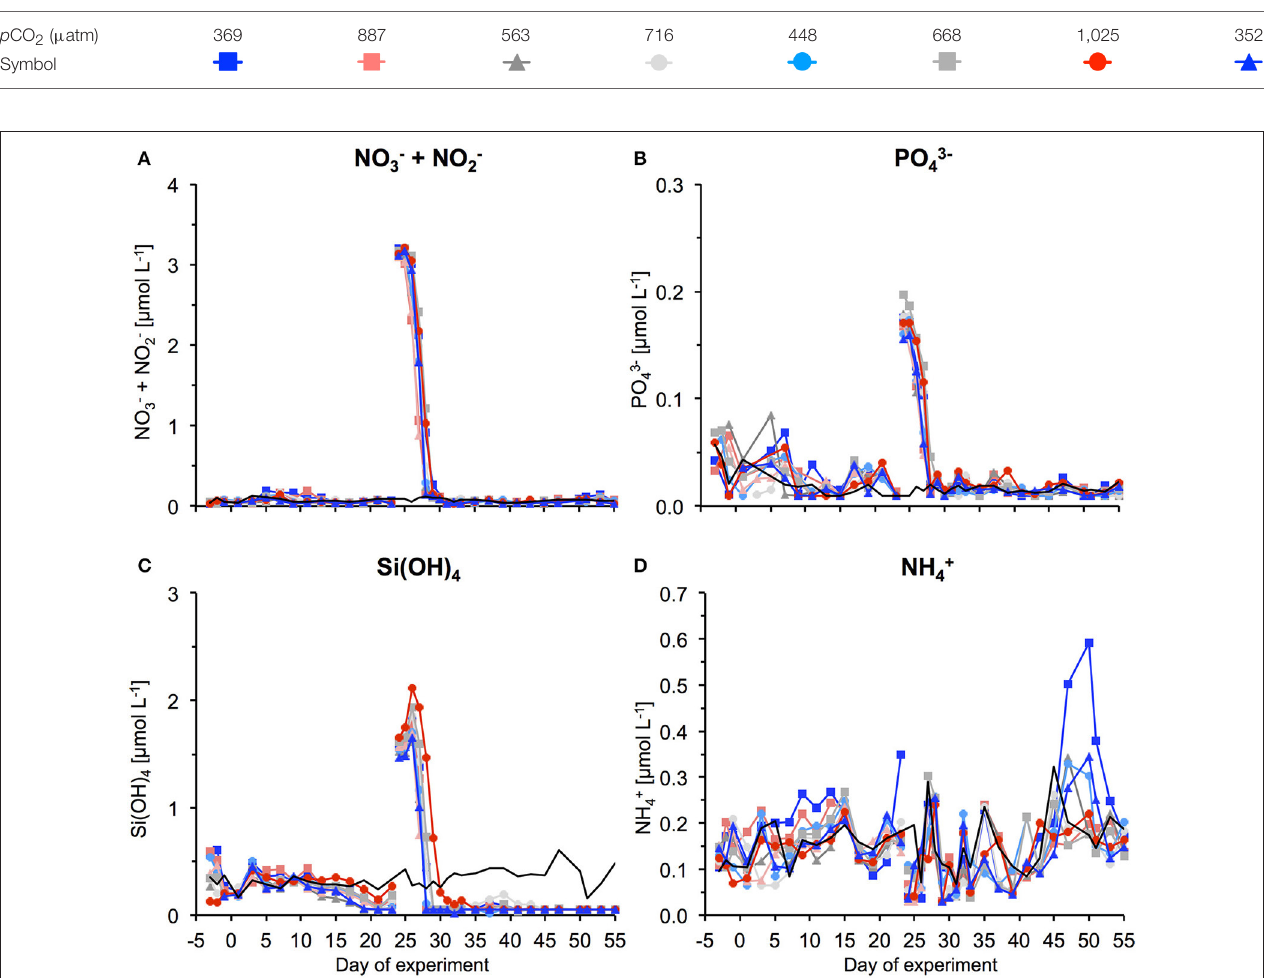
FIGURE 1 | Inorganic nutrient concentrations over the course of the study. (A) NO − 3 + NO − 2 , (B) PO 3 − 4 , (C) Si(OH) 4 , and (D) NH + 4 . The gap and associated change in concentrations between t23 and t25 denotes addition of nutrient-rich deep water to the mesocosms. For color code see Table 1 . Thin black line without symbols shows conditions in water surrounding the